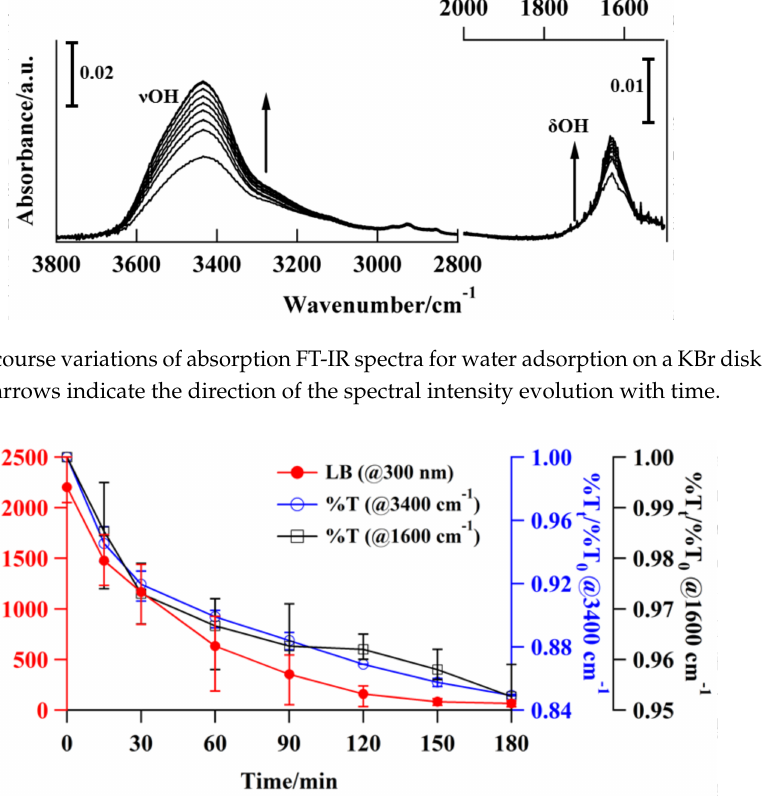
Figure 5. Recovery process of stress-induced LB values (@ 300 nm) of a KBr disk at plus LB max positions, transmission at ν OH stretching (3400 cm − 1 ), and δ OH bending mode bands (1600 cm − 1 ), all plotted as functions of time to indicate the adsorption events of the water molecules on the disk. %T t and %T 0 are FT-IR transmittance at the intermediate and initial stages at the relaxation process, respectively. The data points indicate the mean values ( n = 10) with standard deviation